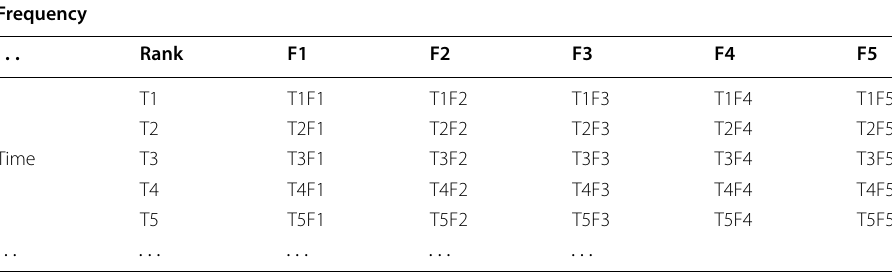
Table 8 Assessment criteria for TF score (time–frequency) Frequency